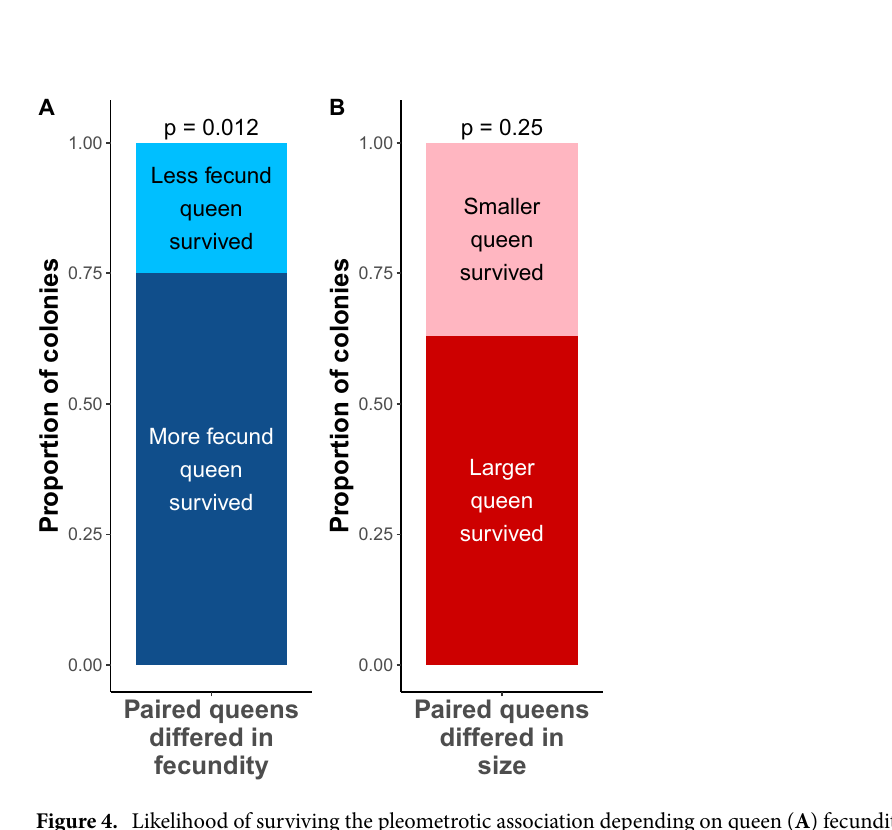
Figure 3. The number of workers increased faster in colonies with two queens (crosses, dotted regression line, slope = 1.01, R 2 = 0.77) compared to those with one queen (squares, solid regression line, slope = 0.59, R 2 = 0.53) (ANOVA: F 1,171.4 = 44.6, P < 0.00001).